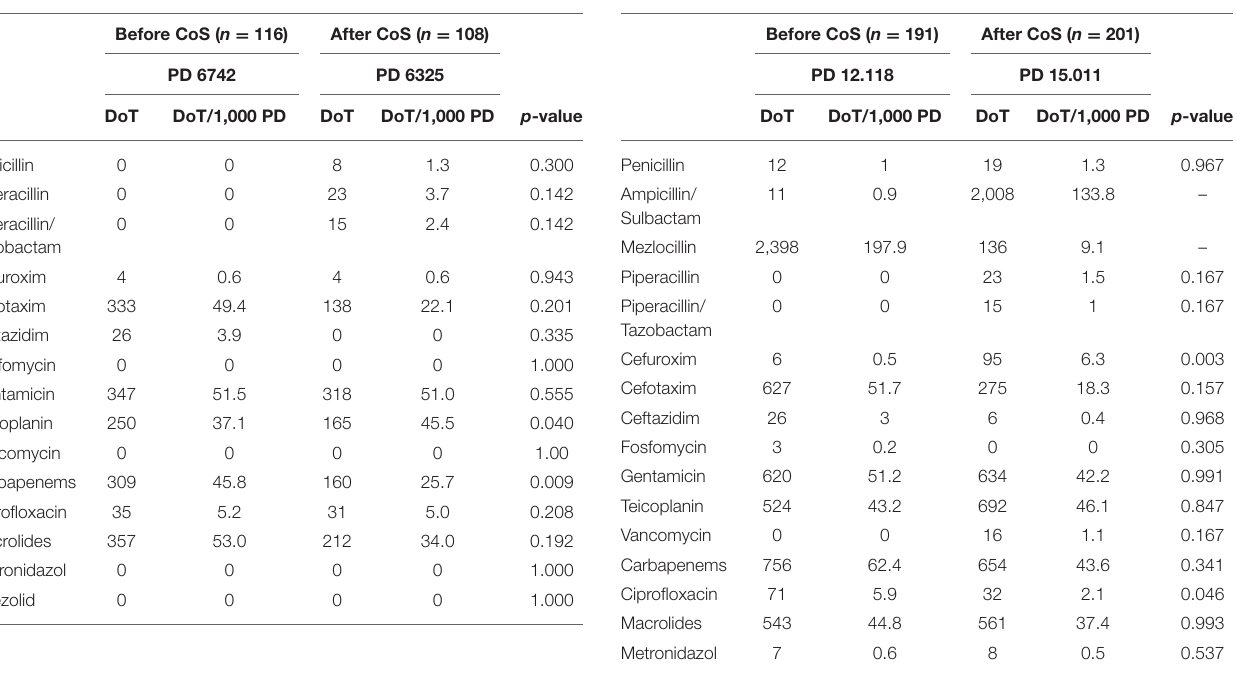
TABLE 7 | Antibiotic use measured by days of therapy (DoT) and DoT per 1,000 patient-days (PD) between the two cohorts before and after the introduction of colonization screening